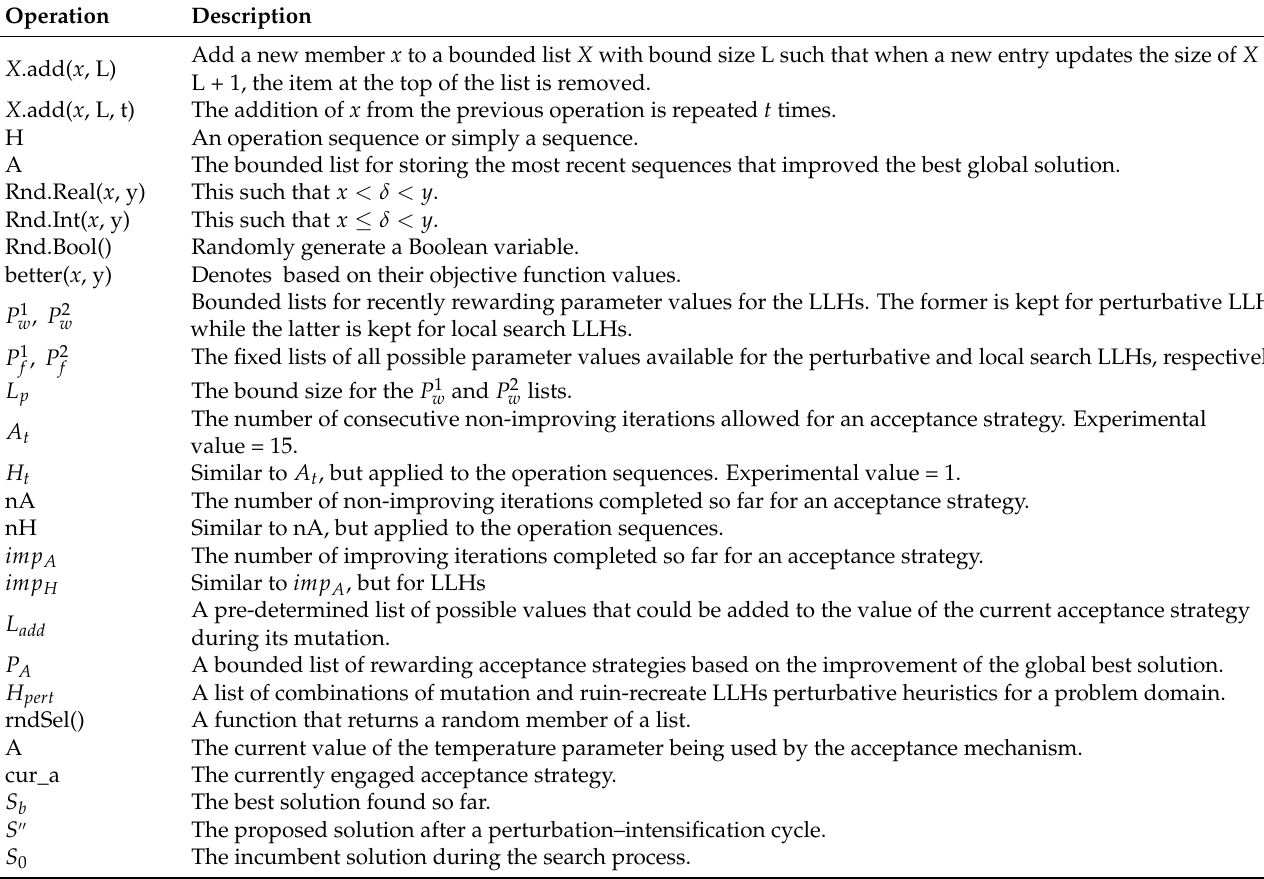
Figure 1. Sample operation sequence in the EA-ILS hyper-heuristic. Table 2. Description of Operations of the EA-ILS